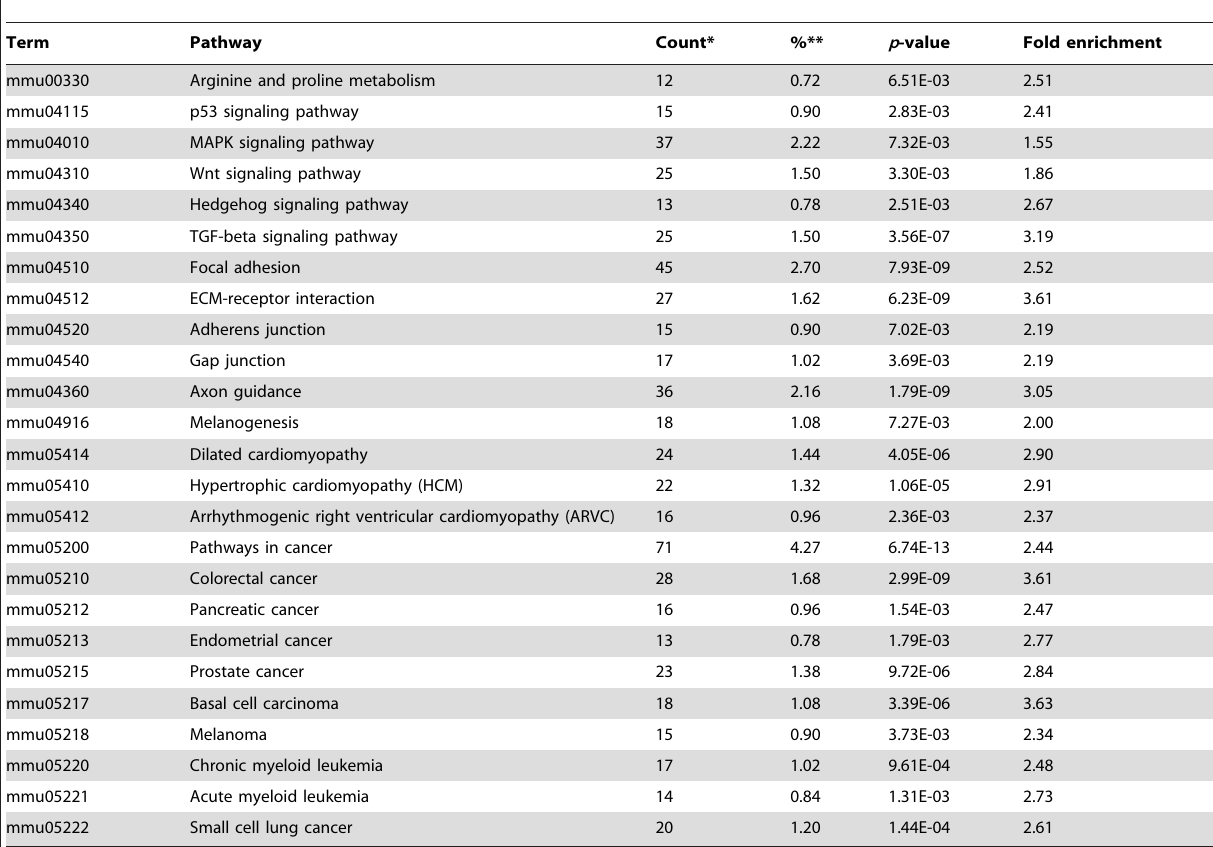
Table 1. List of KEGG pathways enriched by the 1996 DEGs during ESC differentiation.